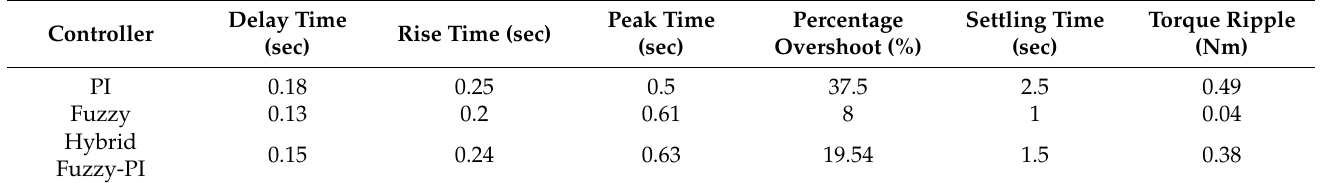
Table 8. Comparison of PI, Fuzzy, and Adaptive Hybrid Fuzzy-PI Controllers (Experiment).